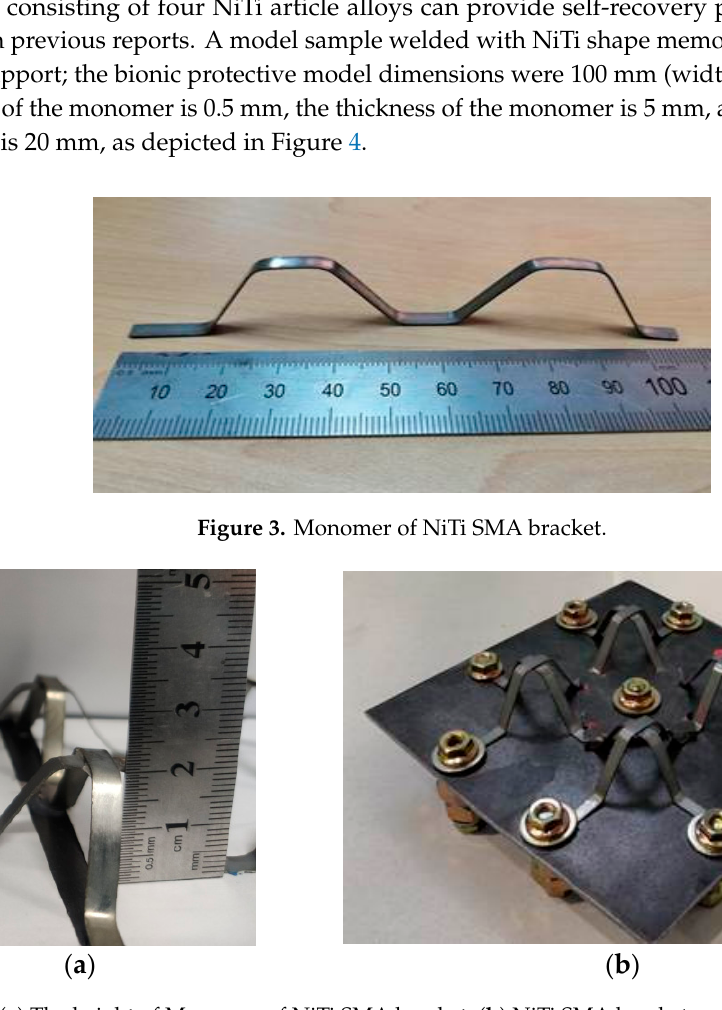
Figure 4. ( a ) The height of Monomer of NiTi SMA bracket, ( b ) NiTi SMA bracket combination module.